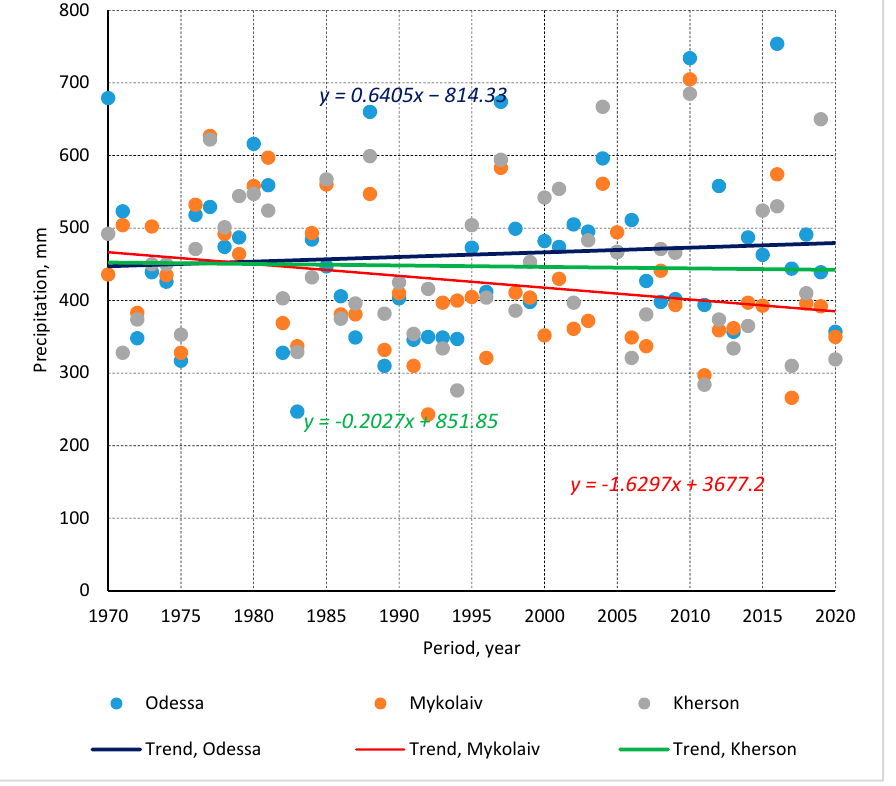
y = 0.6405x − 814.33